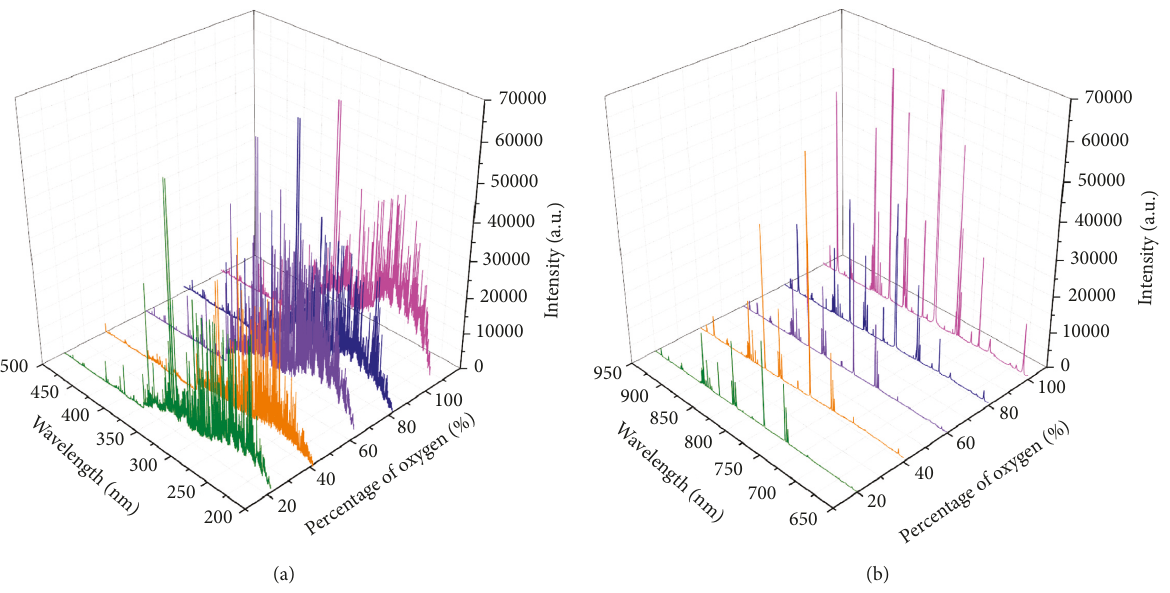
Figure 5: Spectral images of the plasma jet under different O 2 components. (a) Spectral images in the wavelength range of 200–500 nm. (b) Spectral images in the wavelength range of 650–950